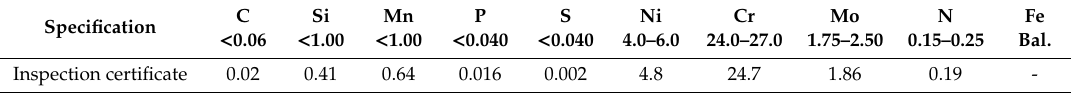
Table 1. Chemical composition of duplex stainless steel ASTM A890 Gr.3A. (mass %). Specification